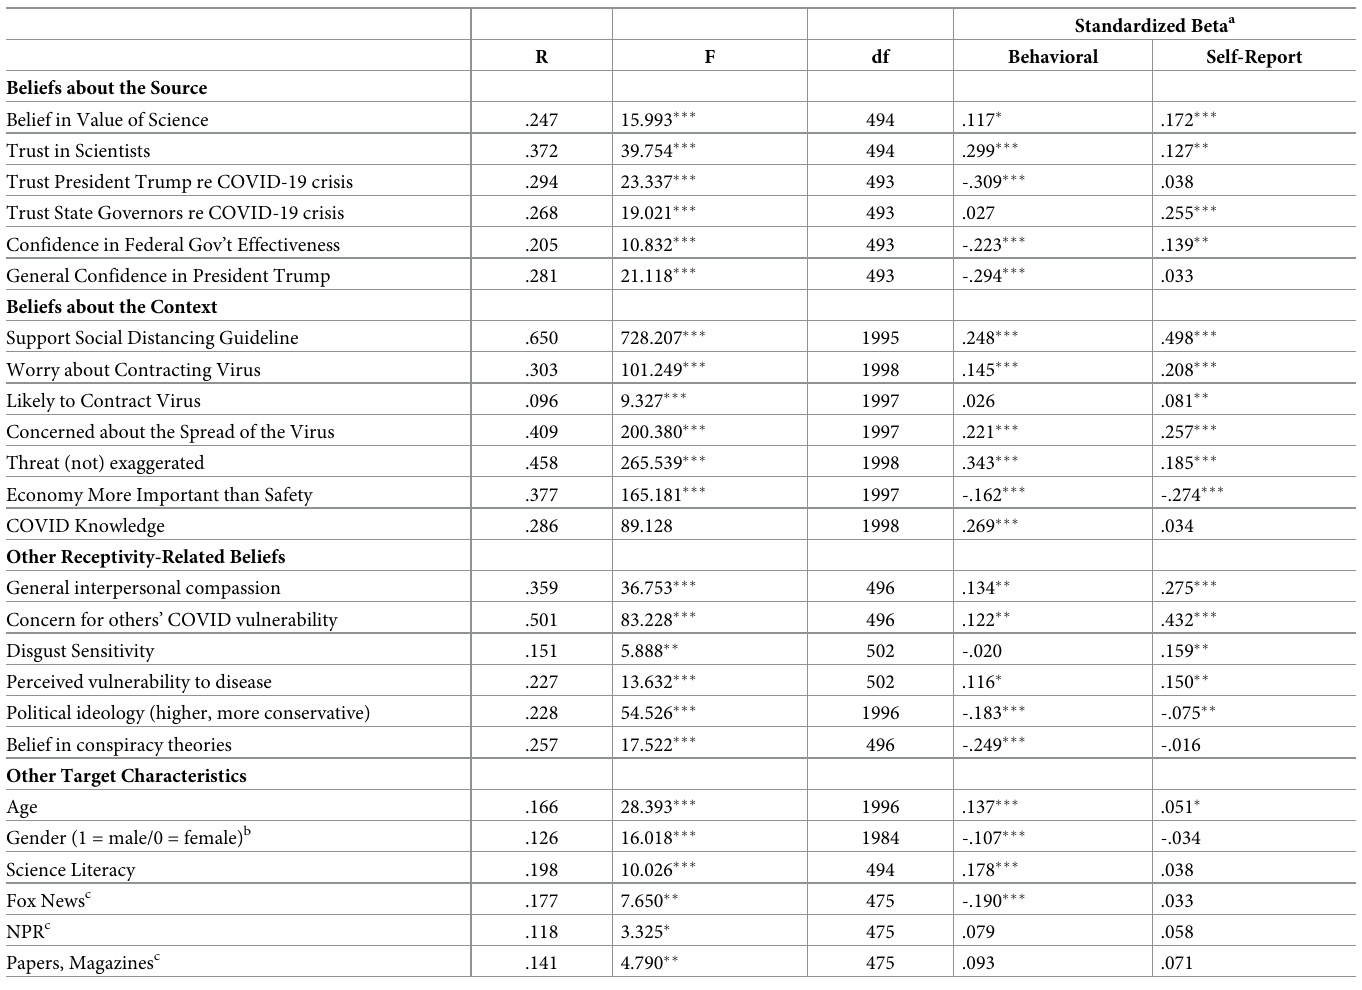
Table 1. Multiple correlations with virtual behavioral and self-reported social